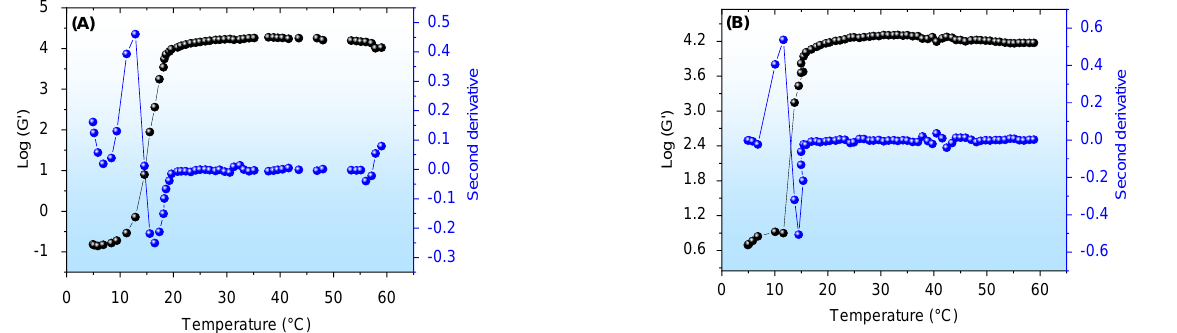
Figure 4. Logarithm of elastic modulus (G ′ in Pa) as a function of temperature, with the corresponding second derivative being ( A ) EOCh-0.5 and ( B ) EOCh-1.0 emulgel. Standard deviations were omitted for clarity; however, in all cases, the coefficient of variation of the replicate analyses was <10%.